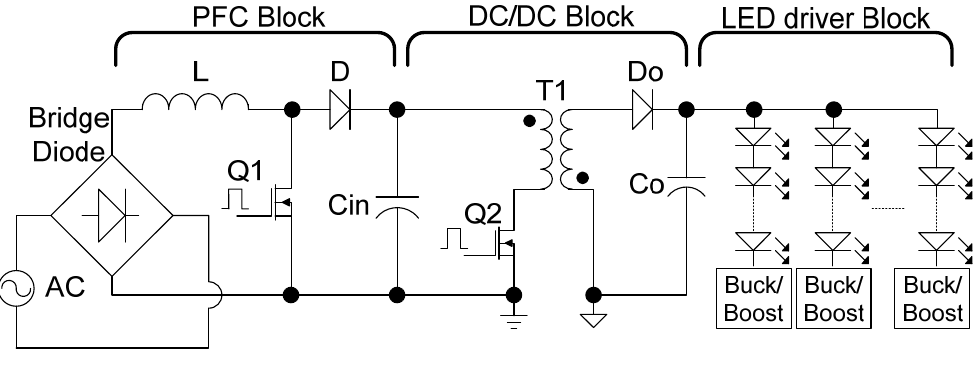
Figure 2. Conventional LED driving circuit.